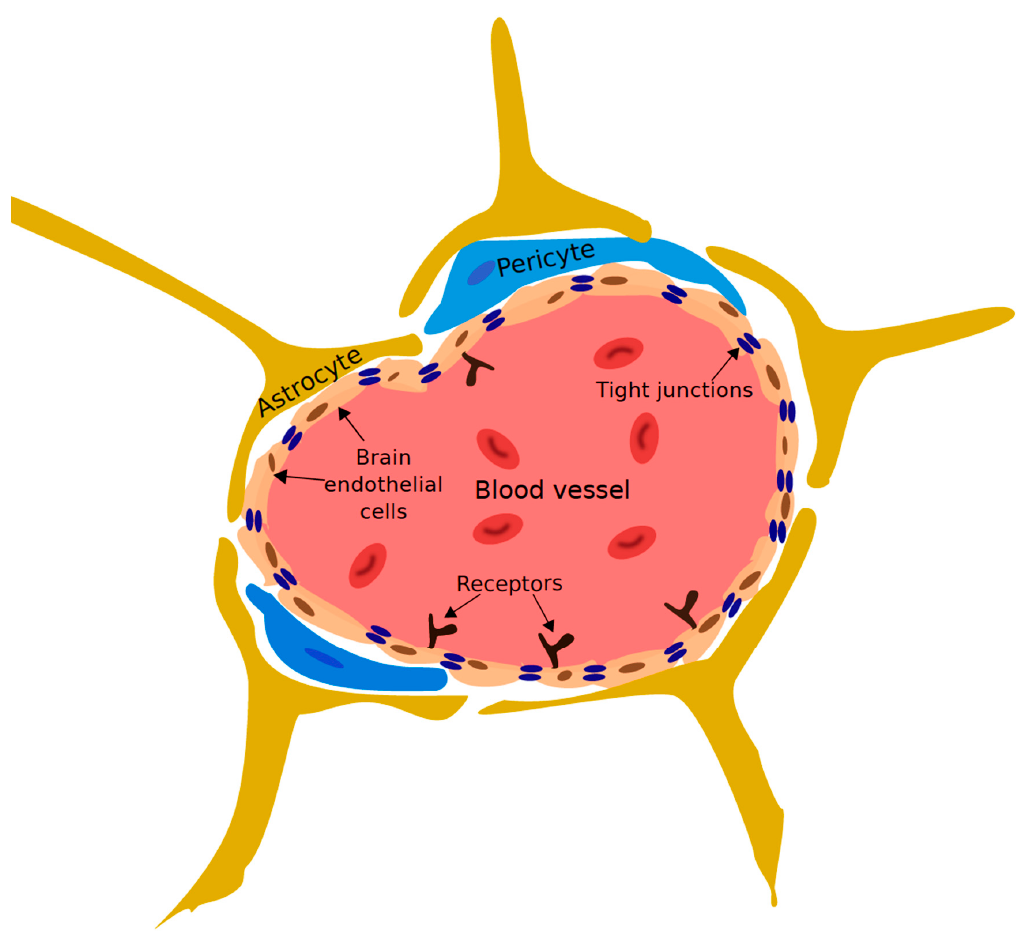
Figure 4. Diagram of the blood-brain barrier (BBB). Brain endothelial cells (BECs) connected by continuous tight junctions line the blood vessels of the cerebrovasculature. Astrocytes, pericytes and other members of neurovascular unit interact with the BECs and support the development and maintenance of the BBB (adapted from